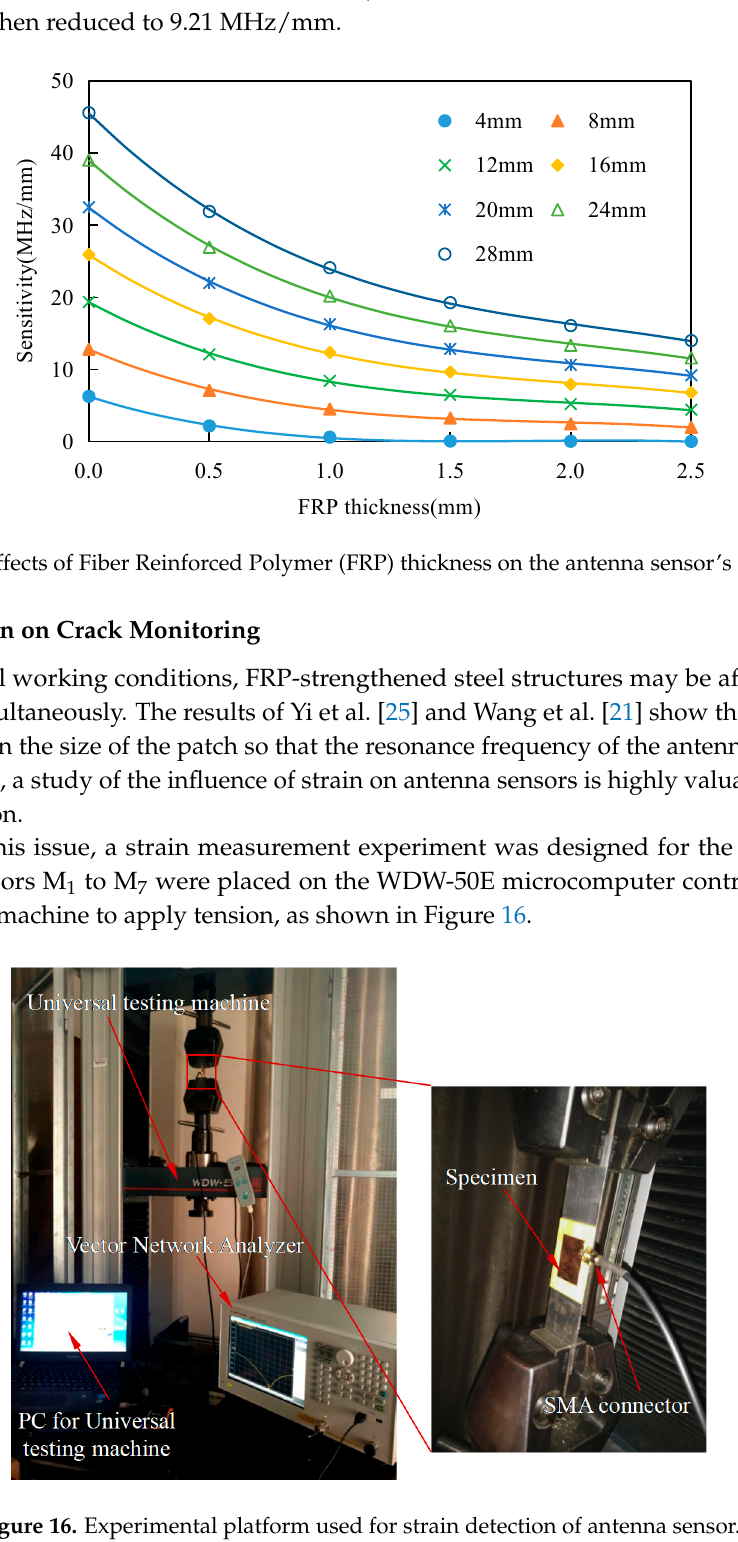
Figure 16. Experimental platform used for strain detection of antenna sensor.